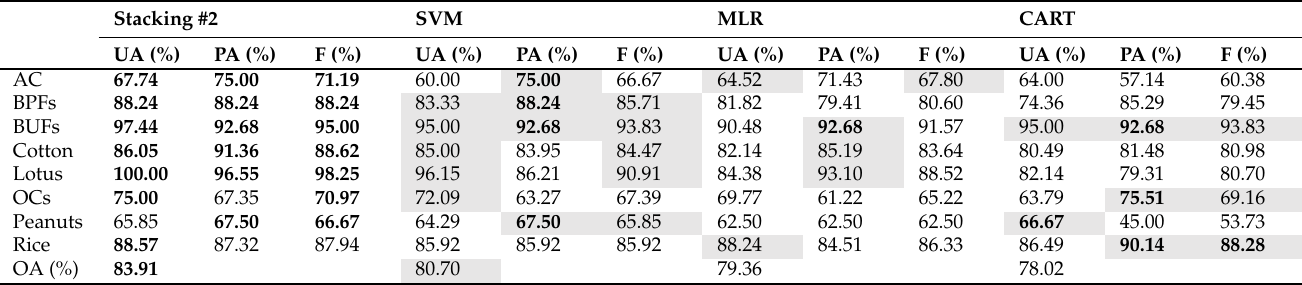
Table 6. Overall accuracies and classwise accuracies obtained by the Stacking #2 model and the SVM, MLR, and CART classifiers.